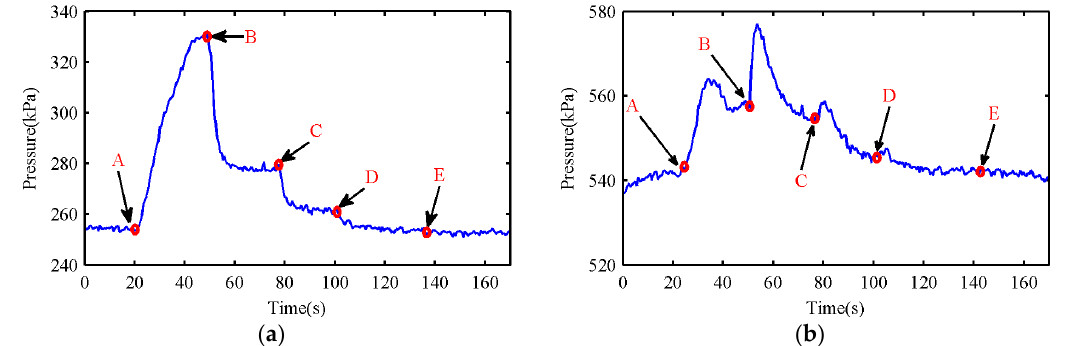
Figure 25. ( a ) First-stage exhaust buffer tank pressure of Experiment 2; ( b ) second-stage exhaust buffer tank pressure of Experiment 2. Table 6. Implementation optimization results of Experiment 1.